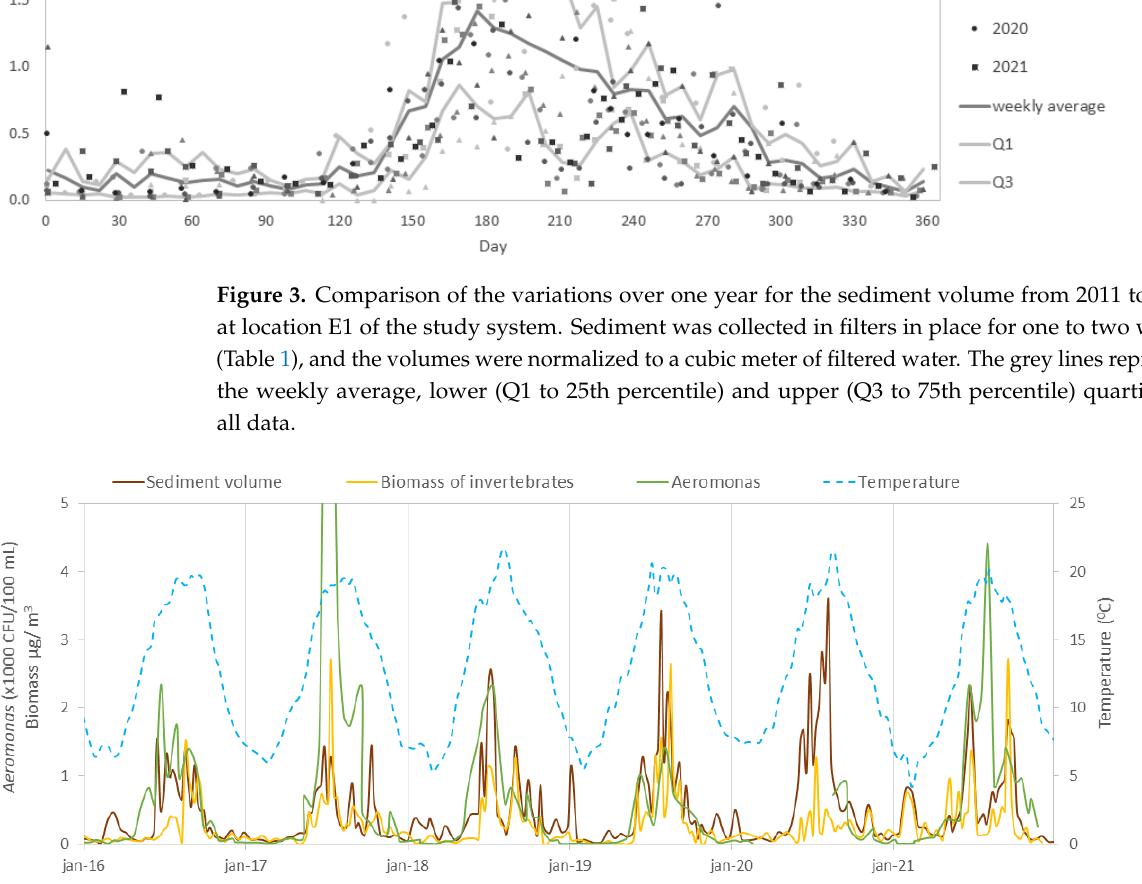
Figure 4. Variations over six years of the sediment volume, water temperature, biomass of inverte- brates (>30 µm), and Aeromonas at location E1 of the study system. Sediment was collected in filters in place for one to two weeks (Table 1), and the sediment volumes and biomass of invertebrates were normalized to a cubic meter of filtered water. Aeromonas data in the period March to August 2020 are not available.